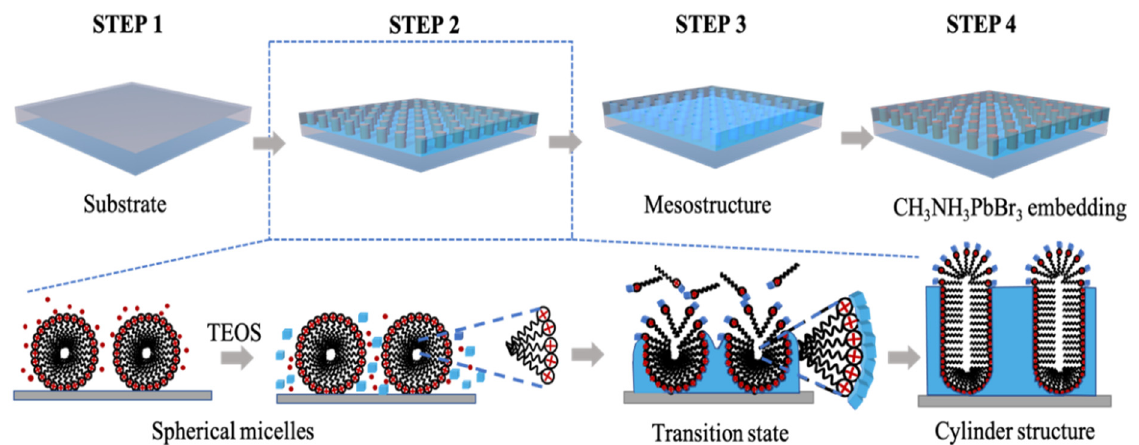
Figure 1. A schematic representation of preparation process of embedding the MAPbBr 3 in a mSiO 2 composite structure. Second line shows the formation process of ordered mesoporous silica films with perpendicular mesochannels by the Stöber solution spontaneous growth procedure.